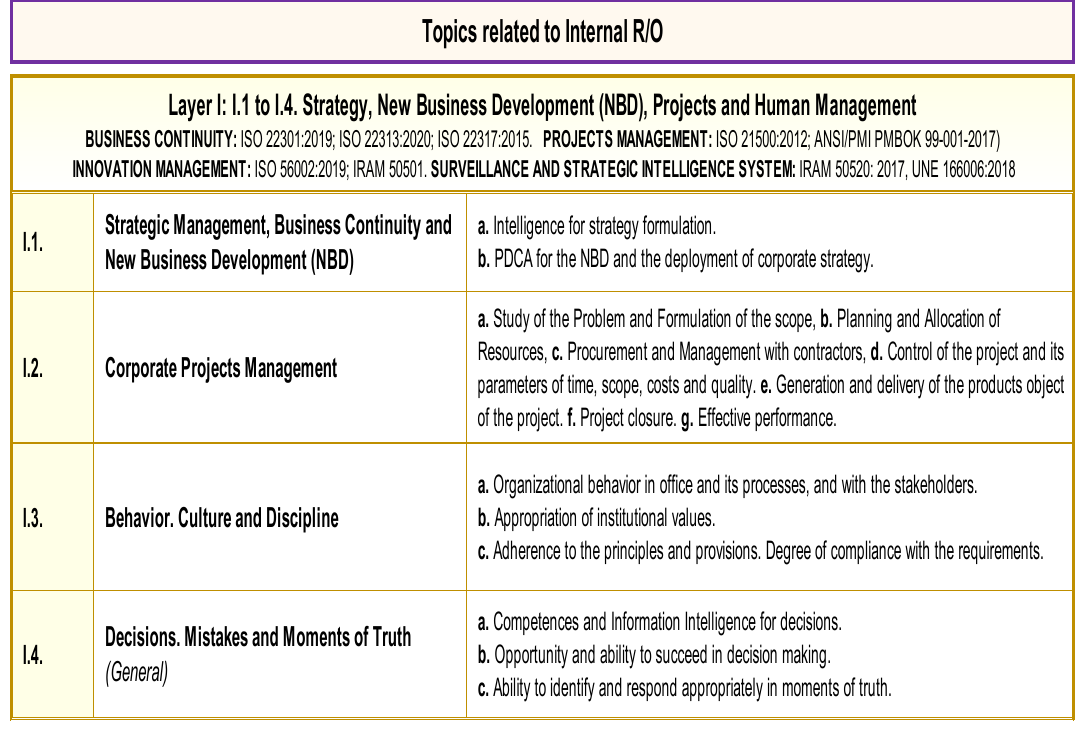
Figure A8. Classification matrix of topics related to external R / O. [14,51,65,101].